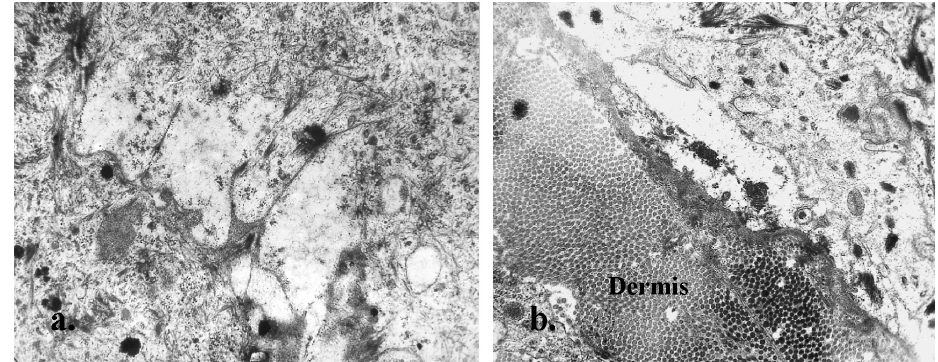
Figure 2 – One hour after the experimental induction a. Cytoplasmic and intercellular vacuolization (x 62.000). b. Vacuolization at the dermal-epidermal junction (x 62.000)